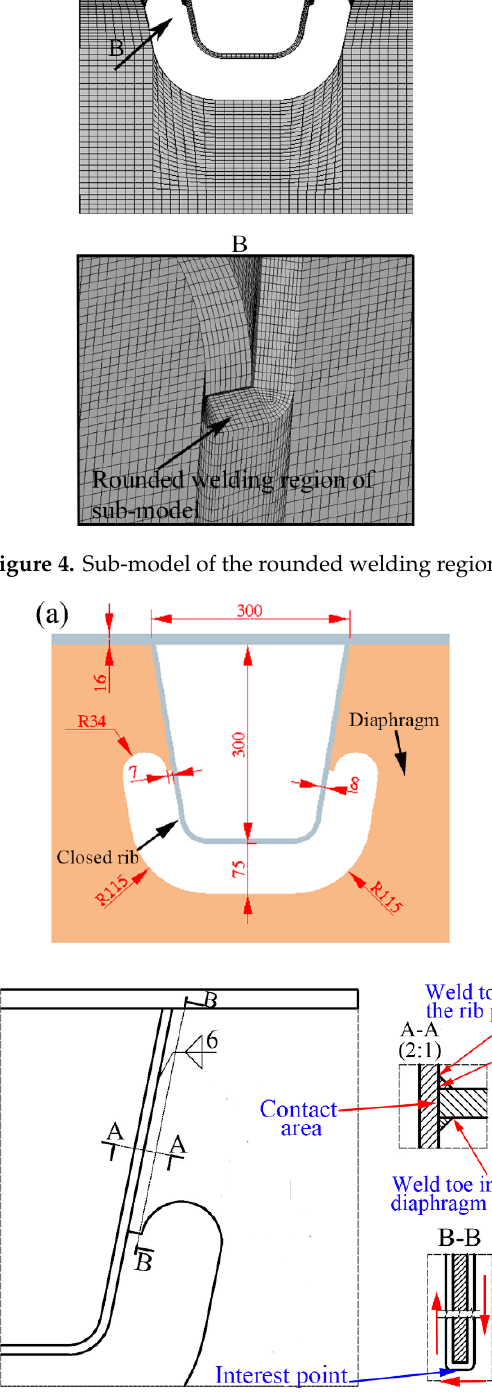
Figure 5. ( a ) Structure schematic diagram (in mm) and ( b ) the fillet weld between closed rib and diaphragm (in diaphragm (in mm).